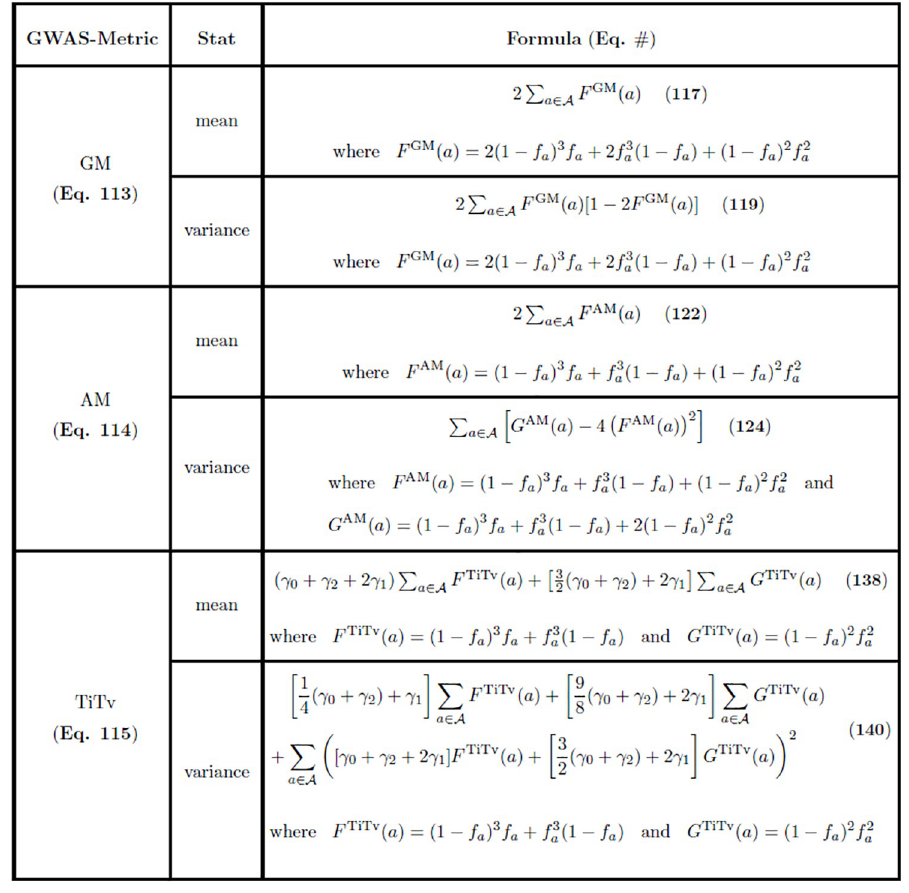
Fig 8. Asymptotic estimates of means and variances of genotype mismatch (GM) (Eq 113), allele mismatch (AM) (Eq 114), and transition-transversion (TiTv) (Eq 115) distance metrics in GWAS data ( p � 1). GWAS data � B ð 2 ; f Þ , where f a for all a 2 A are the probabilities of a minor allele occurring at locus a . For the TiTv distance X ia a metric, we have the additional encoding that uses γ 0 = P(PuPu), γ 1 = P(PuPy), and γ 2 = P(PyPy).